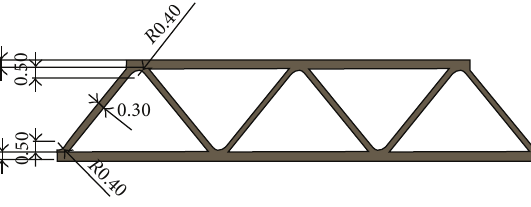
Figure 7: Model of corrugated board with flute height 𝐻 of 5 mm.